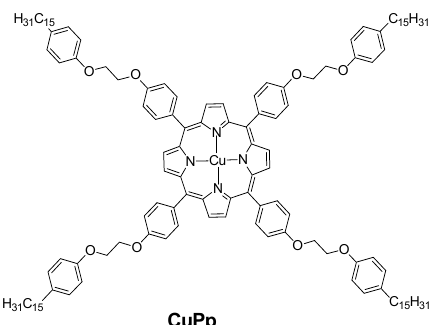
Figure 6. Structural formula of a Cu(II)Por complex used in Ref. [73] for the modification of Au